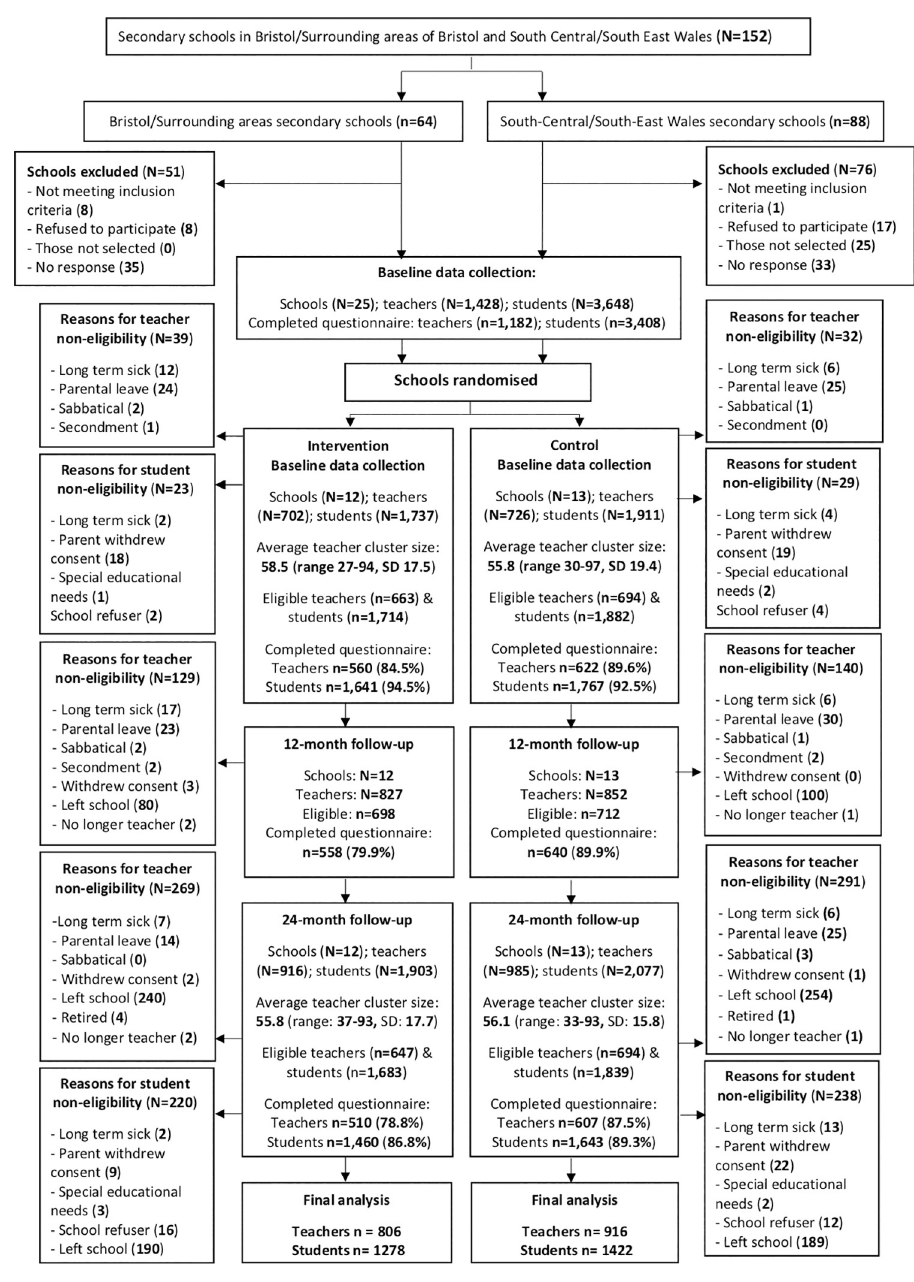
Fig 3. Participant flow through the